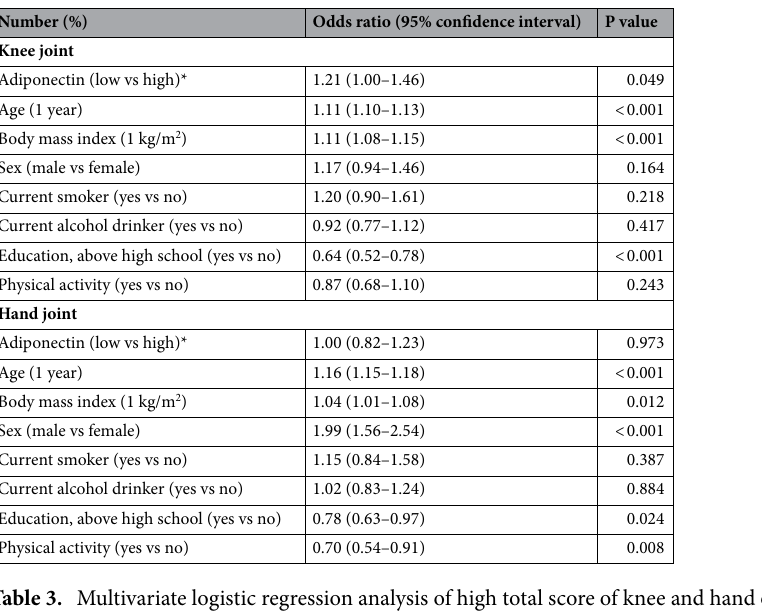
Table 3. Multivariate logistic regression analysis of high total score of knee and hand osteoarthritis based on the median radiographic scores. *Adiponectin levels were dichotomized by the median values.